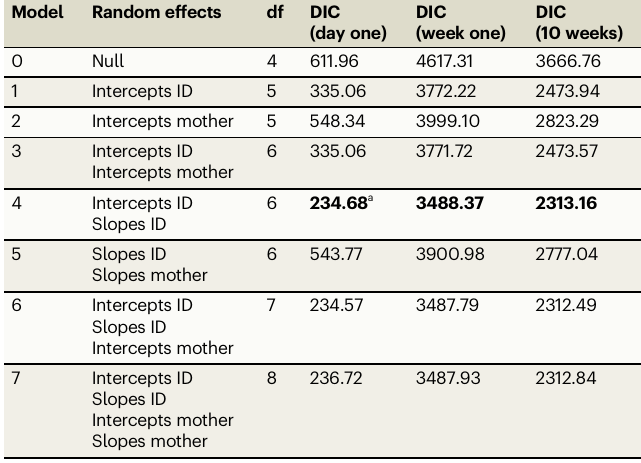
Table 1 | Maternal identity does not explain behavioral individuality Model